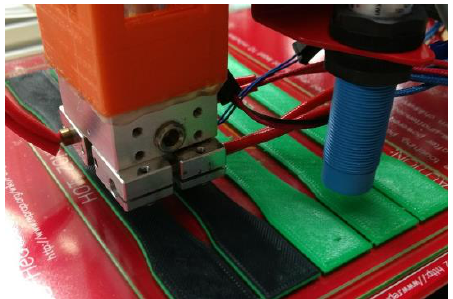
Figure 4. Multi-nozzle extruder while printing ABS-HIPS-ABS specimen.